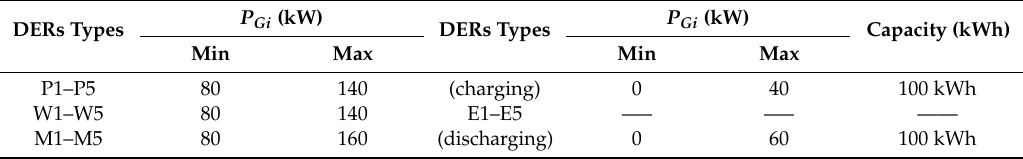
Table 2. Capacity limits of